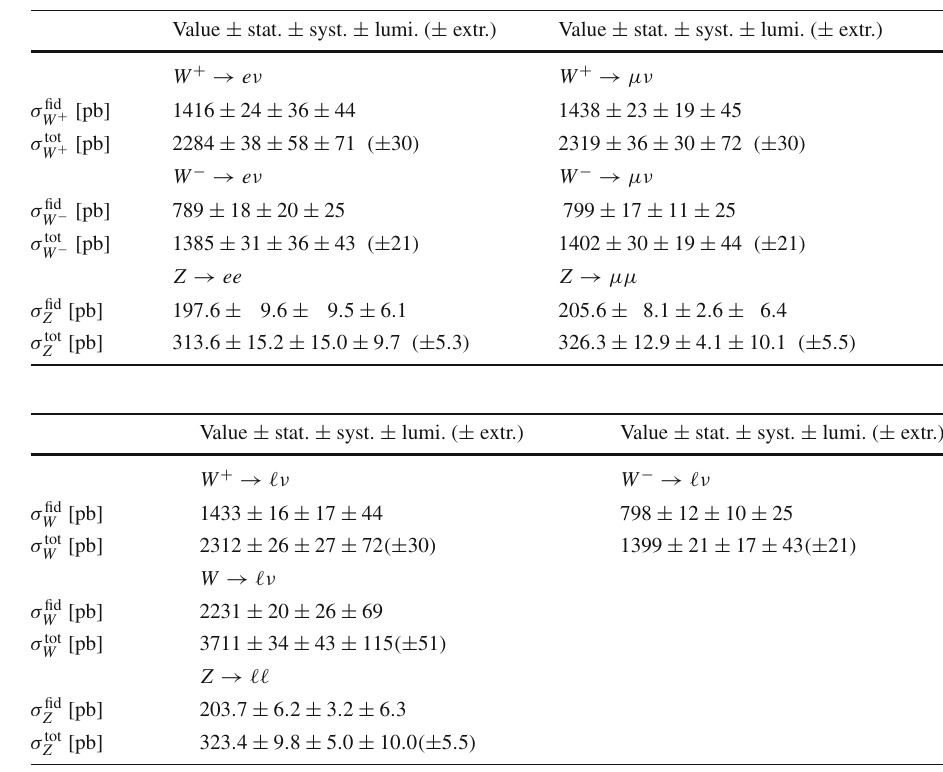
atic uncertainties from the measurement of the integrated luminosity are not included. The background distributions are neglected here, but would not be visible if included. The lower panel shows the ratio of the data to the prediction